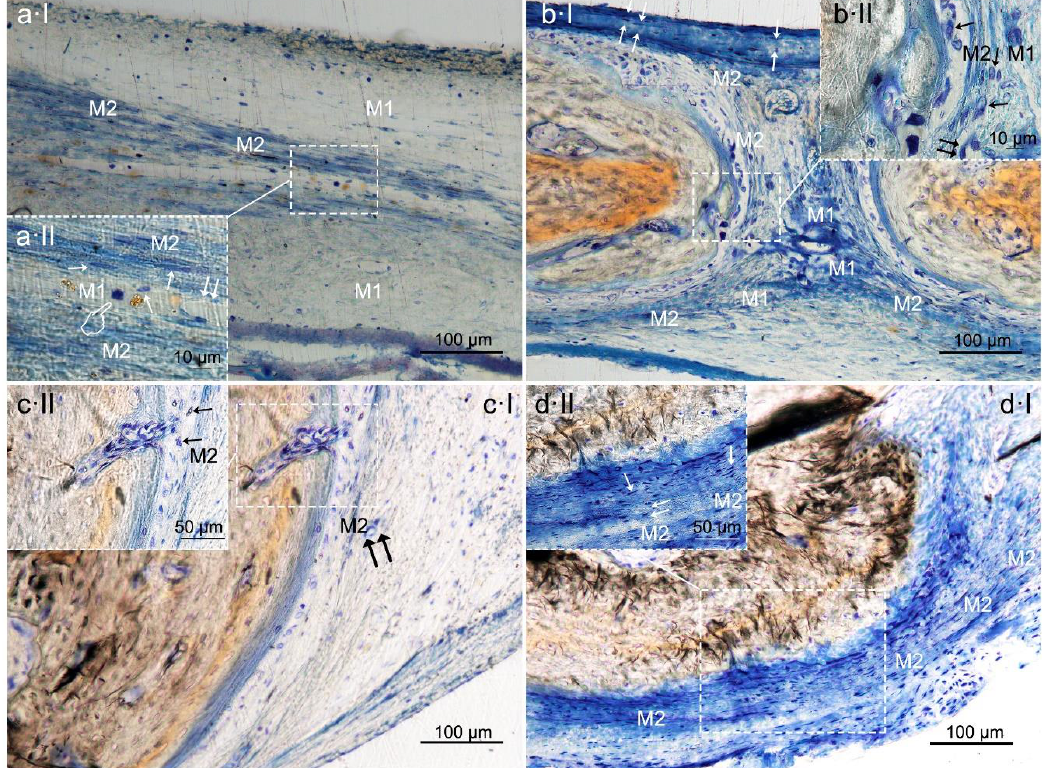
Figure 7. Bone histology images obtained after using HOOC-Si ( a ), Zn-HOOC-Si ( b ), Dox-HOOC-Si ( c ) loaded membranes, and blank control (no membrane) ( d ), by dye with toluidine blue to visualize macrophages at the bone defect, at 6 weeks of healing time. M1 (pointers) and M2 (single arrows) macrophages were observable at the centre of the defect (Figure 7a). M1 showed increase size and granularity, nearly round or irregularly spherical shape, with more lamellipodia. M2 exhibited elongated or spindle-shaped appearance and long filopodia, with a loss of nuclear volume and induction of chromatin condensation (Figure 7a–d). Small vessels are also shown (double arrows). Cells have invaded the experimental tested membrane (faced arrows) (Figure 7bI). Table 7. Macrophages counts (cells/mm 2 ) and characterization by histomorphometric profile at the region of interest (Mean ± Standard Error).